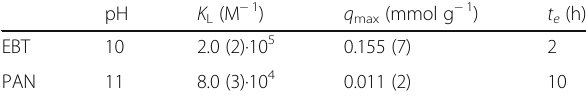
Table 1 Sorption isotherms and kinetics of EBT and PAN on CC. Parameters of the fitting according to the Langmuir